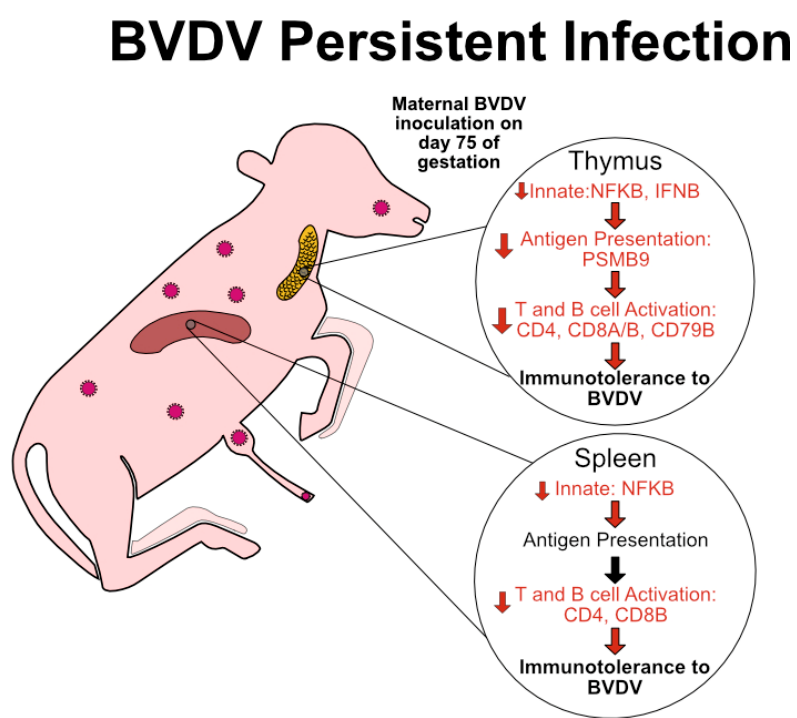
Figure 6. Graphic summarizing significant changes in fetal immune responses based on type of infection and tissue, as interpreted by RT-qPCR analysis. BVDV transient infection represents a fetal infection after gestational day 160 in which the fetus is able to clear the virus. Trends include an upregulation in genes associated with the innate immune response. Day 190 of collections may have been too early to capture an adaptive immune response in TI fetuses. However, we hypothesize that these pathways contribute to BVDV clearance in TI animals. BVDV-persistent infection represents a fetal infection before gestational day 120 in which the fetus is unable to clear the virus. Trends include a drastic down-regulation of the innate and adaptive branches of the immune system, and may lead to immunotolerance of the fetus to BVDV. In future studies, TI BVDV clearance and PI immunotolerance will be studied further with protein targets and flow cytometry. Green text, up arrow left of text, and listed genes represent pathways and genes which were significantly upregulated, as determined by RT-qPCR. Red text, down arrow left of text, and listed genes represent pathways and genes which were significantly downregulated as determined by